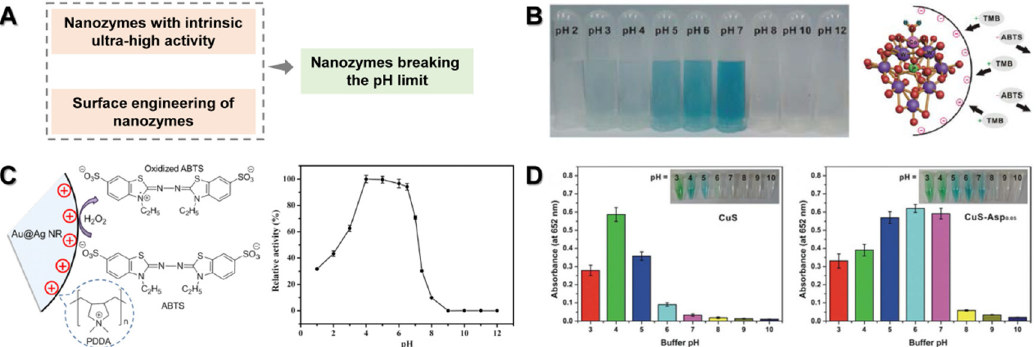
Figure 6. ( A ) Strategies to obtain nanozymes that can break the pH limit. ( B ) Co-based nanozyme showing good peroxidase-like activity in a neutral solution (reprinted with permission from Ref. [96]). ( C ) Au@Ag NRs modified with positively charged PDDA, showing a pH-dependent peroxidase-like activity (reprinted with permission from Ref. [101]). ( D ) Surface modification of nanoscale CuS with aspartic acid to gain favorable peroxidase-mimetic activity at neutral pH (reprinted with permission from Ref. [100]).